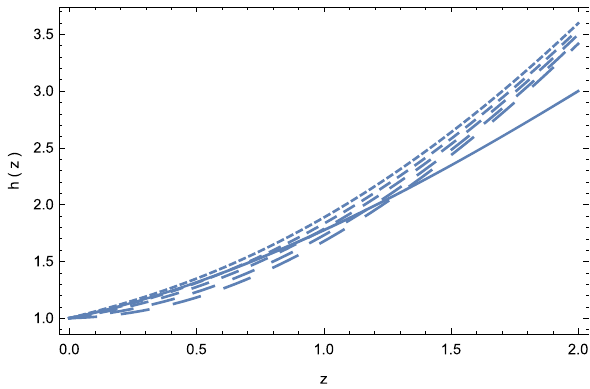
Fig. 1 Variation as a function of the redshift of the dimension- less Hubble function h ( z ) for the geometry-matter coupling function (cid:12) (cid:11) ˜ Q , ˜ T = α ˜ Q + β ˜ T for α = − 1 . 95, M = 0 . 95, and for differ- F ent values of β : β = − 2 . 64 (dotted curve), β = − 2 . 78 (short dashed curve), β = − 2 . 91 (dashed curve), β = − 3 . 07 (long dashed curve), and β = − 3 . 24 (ultra-long dashed curve). To integrate the system of cosmological evolution equations we have used the initial conditions h ( 0 ) = 1, (cid:18)( 0 ) = 0 . 555, and (cid:4)( 0 ) = 0 . 568. The solid curve rep- resents the evolution of the Hubble function in the standard (cid:4)